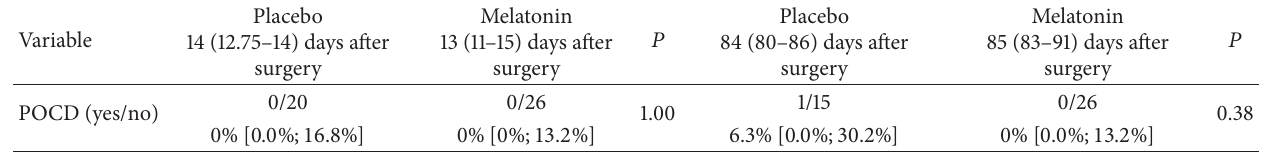
Table 2: Incidence of postoperative cognitive dysfunction (POCD) for melatonin versus placebo.